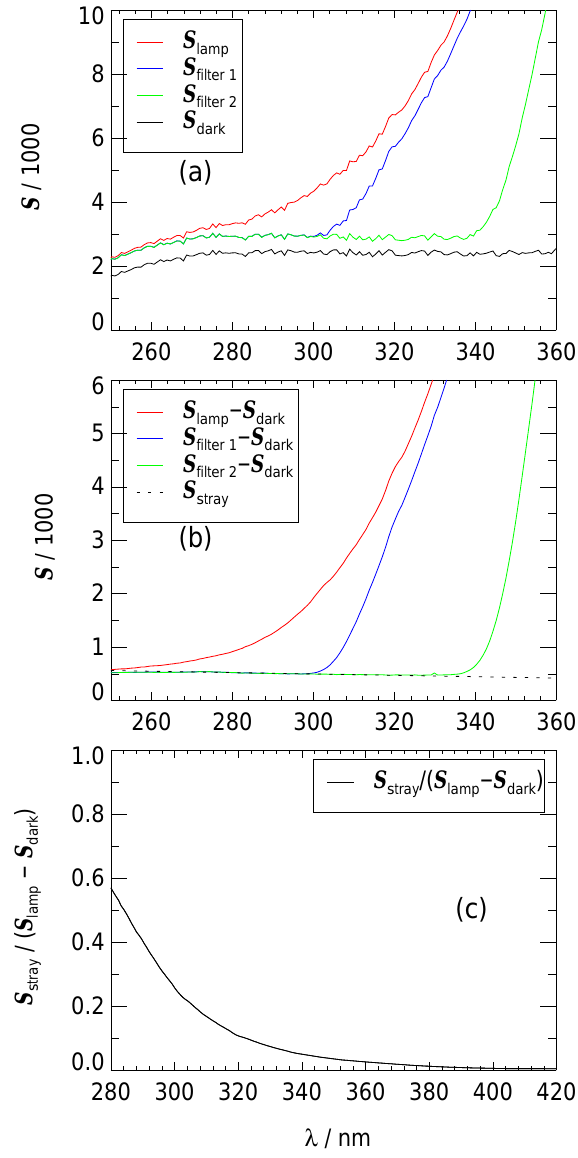
Figure 6. Example signals obtained during laboratory calibrations of instrument 62001 with two cutoff filters at (cid:49)t = 1000ms and a close lamp distance (the index close was skipped for brevity). The wavelength range relevant for the determination of stray-light signals is zoomed in. Saturation occurred around 400nm for this integration time. (a) Total signals of lamp radiation with no filter ( S lamp ), of lamp radiation with a WG320 filter ( S filter 1 ), of lamp radiation with a WG360 filter ( S filter 2 ), and dark signals ( S dark ). (b) After subtraction of dark signals, stray-light signals were es- timated by linear regressions in a range of 270–300nm and ex- trapolated over the whole spectral range (dashed lines) before final subtraction. (c) Signal contribution of stray light in the most atmo- spherically relevant wavelength range. Similar figures for the other instruments are shown in the